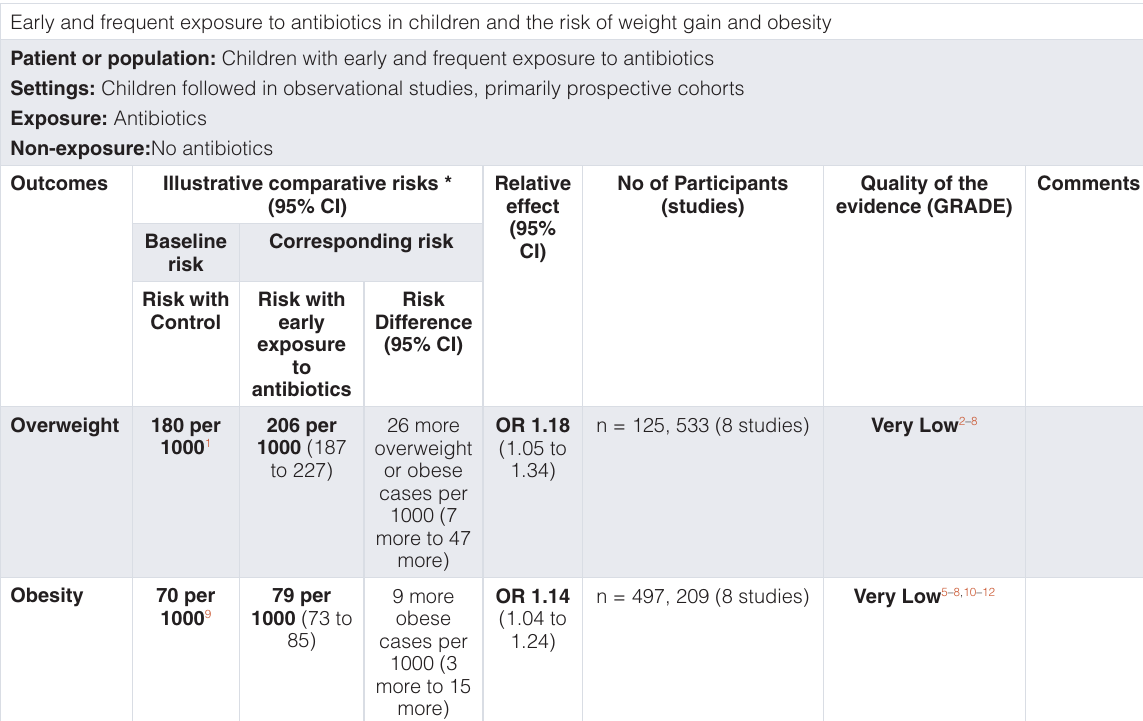
Table 3. GRADE summary of